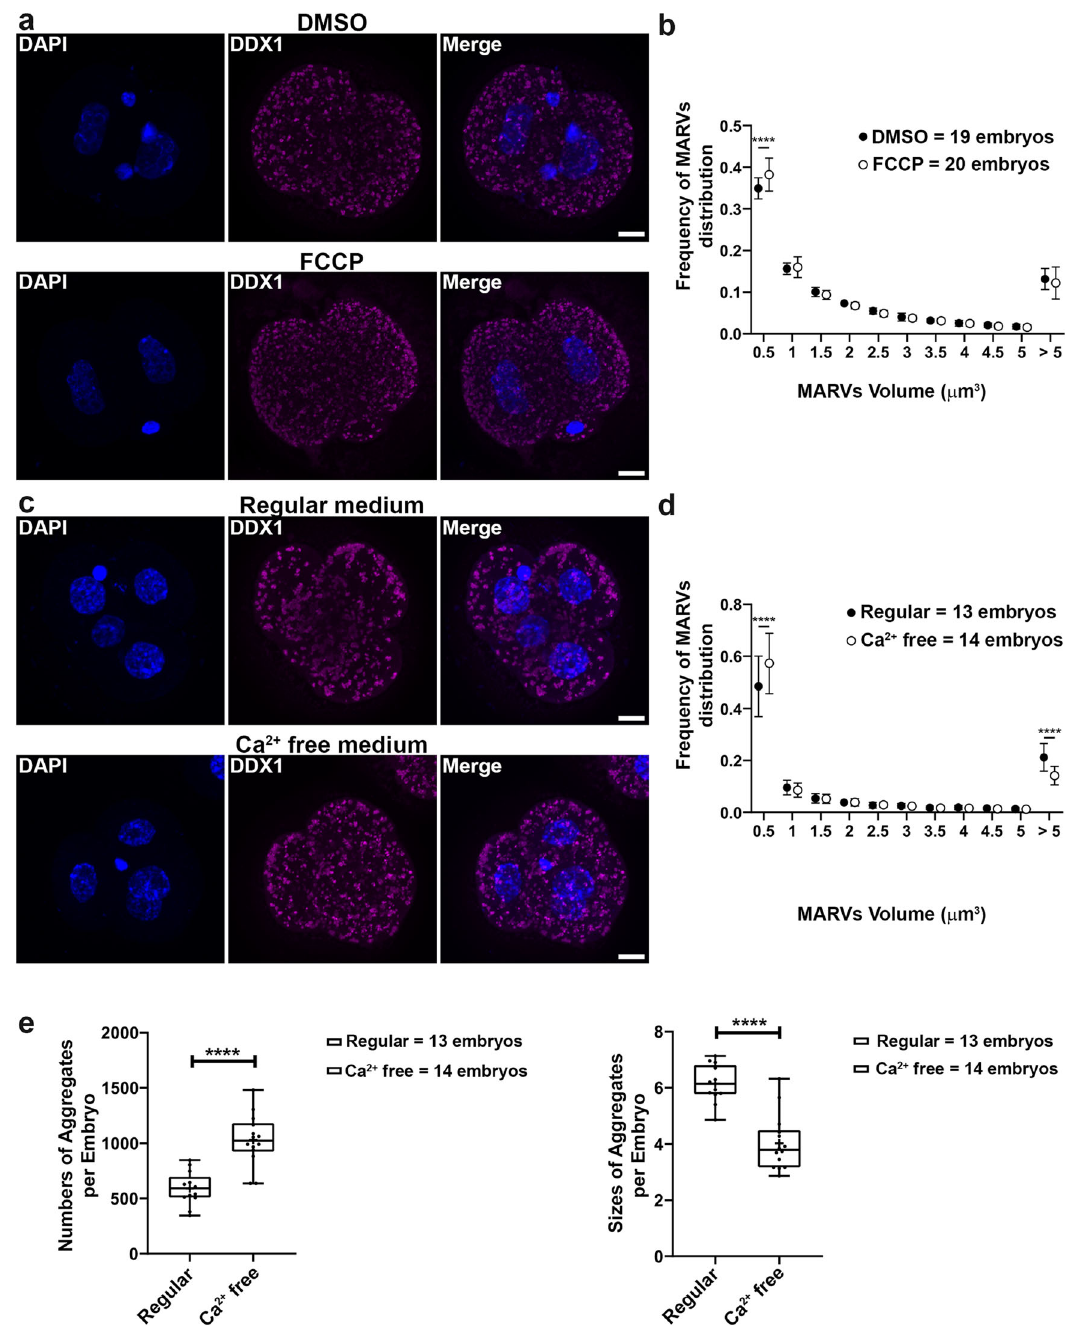
Fig. 3 Sizes of MARVs are linked to mitochondrial potential and Ca 2 + distribution/supply. Two-cell embryos were collected from natural matings. a Embryos were treated with 5 µ M FCCP for 2 h. DDX1 aggregates showed reduced sizes in FCCP-treated embryos compared to DMSO control (DDX1, magenta; DAPI, blue). b Statistical analysis of ( a ) with data from 4 pairs of wild-type natural matings. Data were plotted with Prism. Statistical analysis was performed with two-sided multiple t -test using the Holm-Sidak method, with alpha = 0.05. ****indicates p < 0.0001 (with the exact p < 1E-06). Each circle represents the mean value, and the error bars represent standard deviation. Solid circles represent DMSO-treated control; empty circles represent FCCP- treated. c Embryos cultured in Ca 2 + free medium for 24 h show reduced sizes of DDX1 aggregates compared to embryos cultured in regular Ca 2 + containing medium. d Size distribution analysis of ( c ) with data from 3 pairs of wild-type natural matings. Data were plotted with Prism. Statistical analysis was performed with two-sided multiple t -test the Holm-Sidak method, with alpha = 0.05. ****indicates p < 0.0001 (with the exact p < 1E-06 for area <0.5 µ m 3 and p = 4.5E-05 for area >5 µ m 3 ). Each circle represents the mean value, and the error bars represent standard deviation. Solid circles represent regular medium; empty circles represent Ca 2 + -free medium. e Average aggregate numbers and sizes analysis of ( c ). Data were plotted with Prism. Statistical analysis was performed with two-sided Students ’ t -test. ****indicates p < 0.0001 (with the exact p = 4.26E-06 for left panel and p = 8.29E-07 for right panel). Center line, median; box limits, 25th and 75th percentiles; whiskers, minimum to maximum. Error bars represent standard deviation. Maximum intensity projections of the Z-stack images of each stage are shown in ( a ), ( c ). Z-stacks were used for all statistical analyses in this fi gure. Scale bars = 10 µ m.